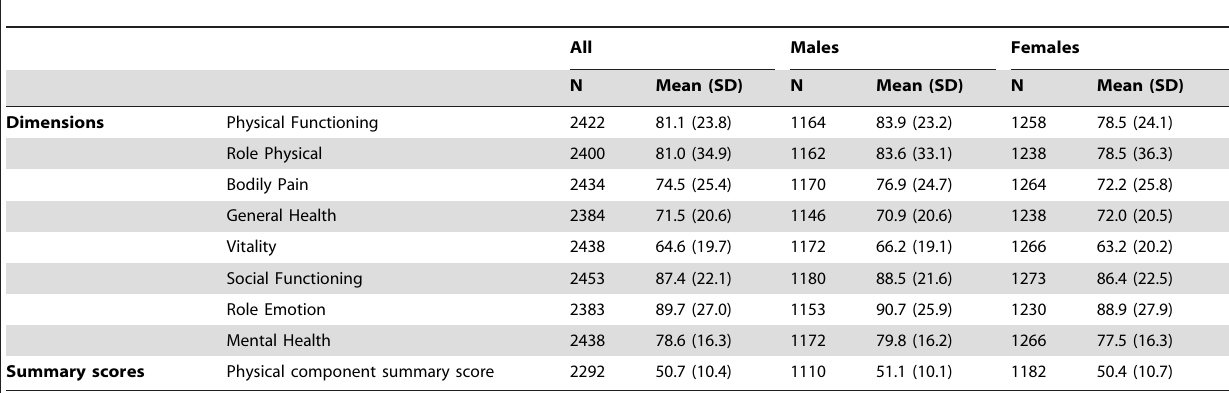
Table 1. Mean (SD) scores for the eight dimensions and the two summary measures of SF-36 for males and females aged 60–64